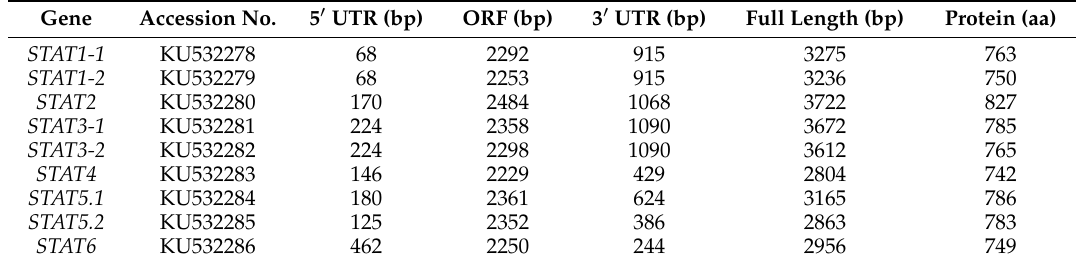
Table 1. The sequence information of STATs (signal transducers and activators of transcription proteins).